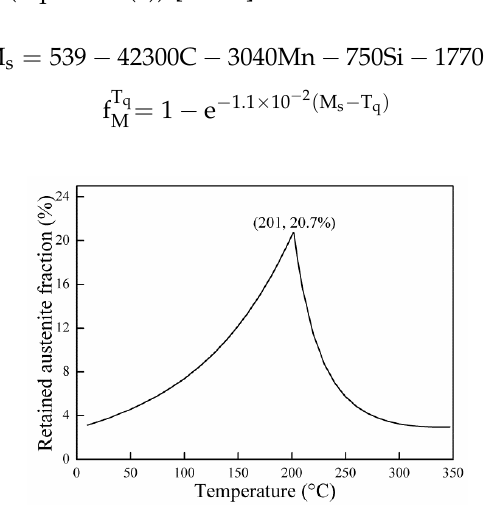
Figure 1. Theoretical calculation of the optimum quenching temperature.